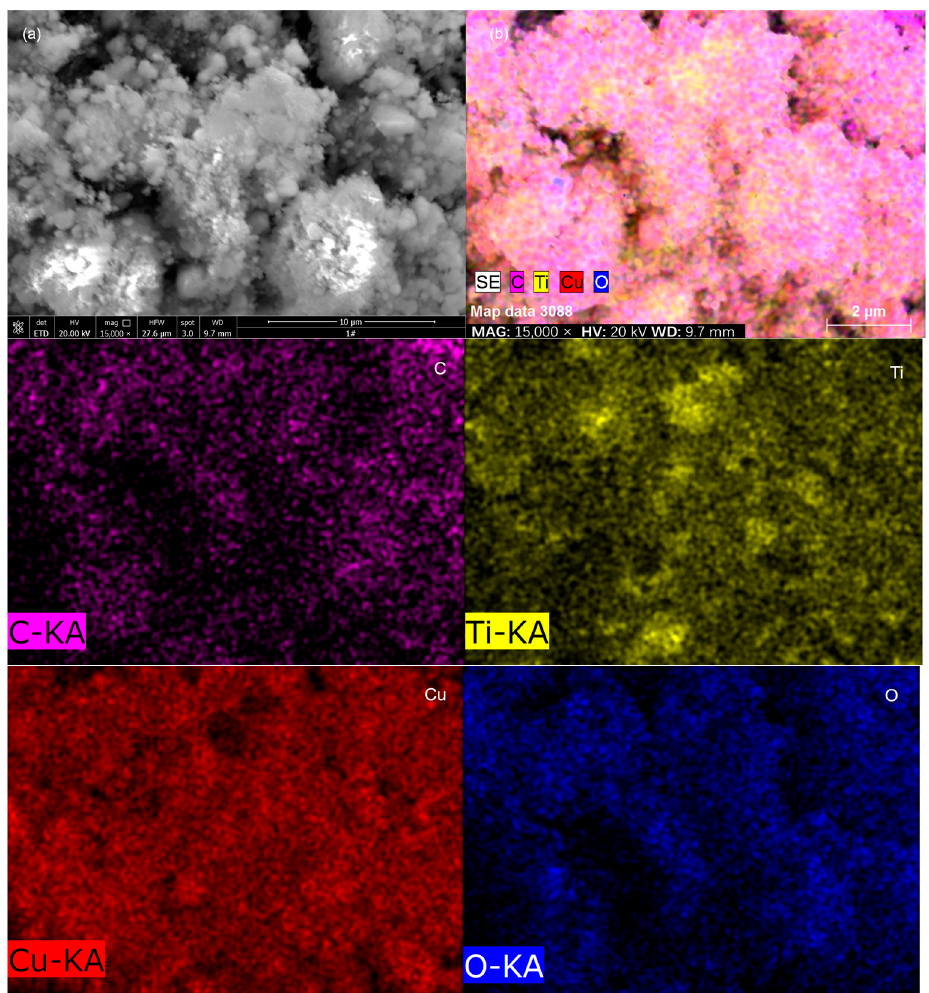
Figure 2. SEM image of ( a ) Cu/Ti 3 C 2 T x and ( b ) EDS mapping of Cu/Ti 3 C 2 T x .